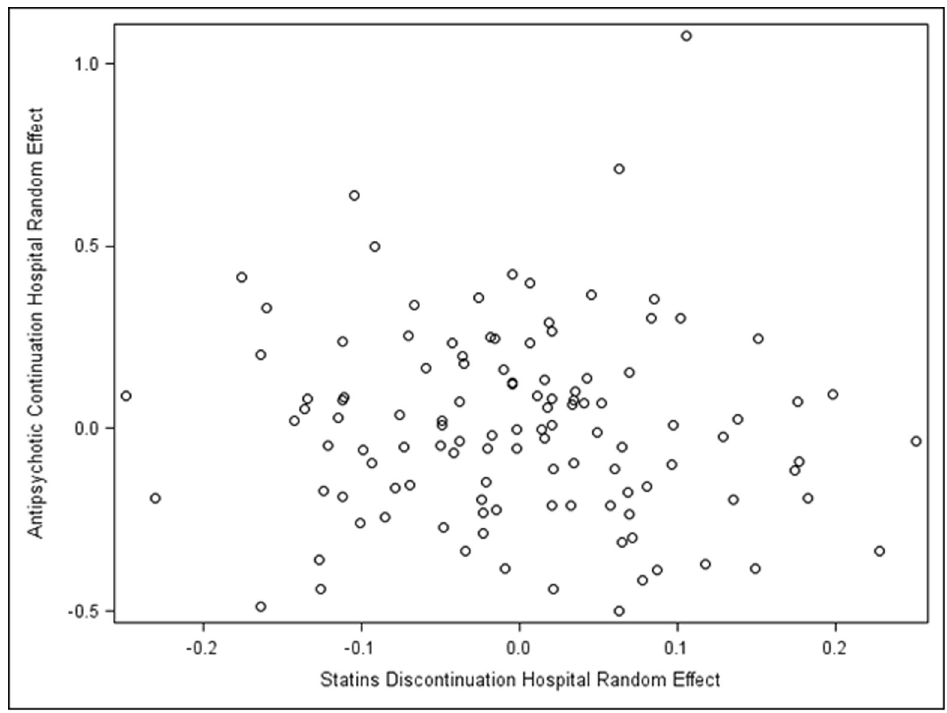
Fig 1. Correlation between statin discontinuation and antipsychotic continuation at VA hospitals. Adjusted for all patient-level factors and on the log-odds scale.